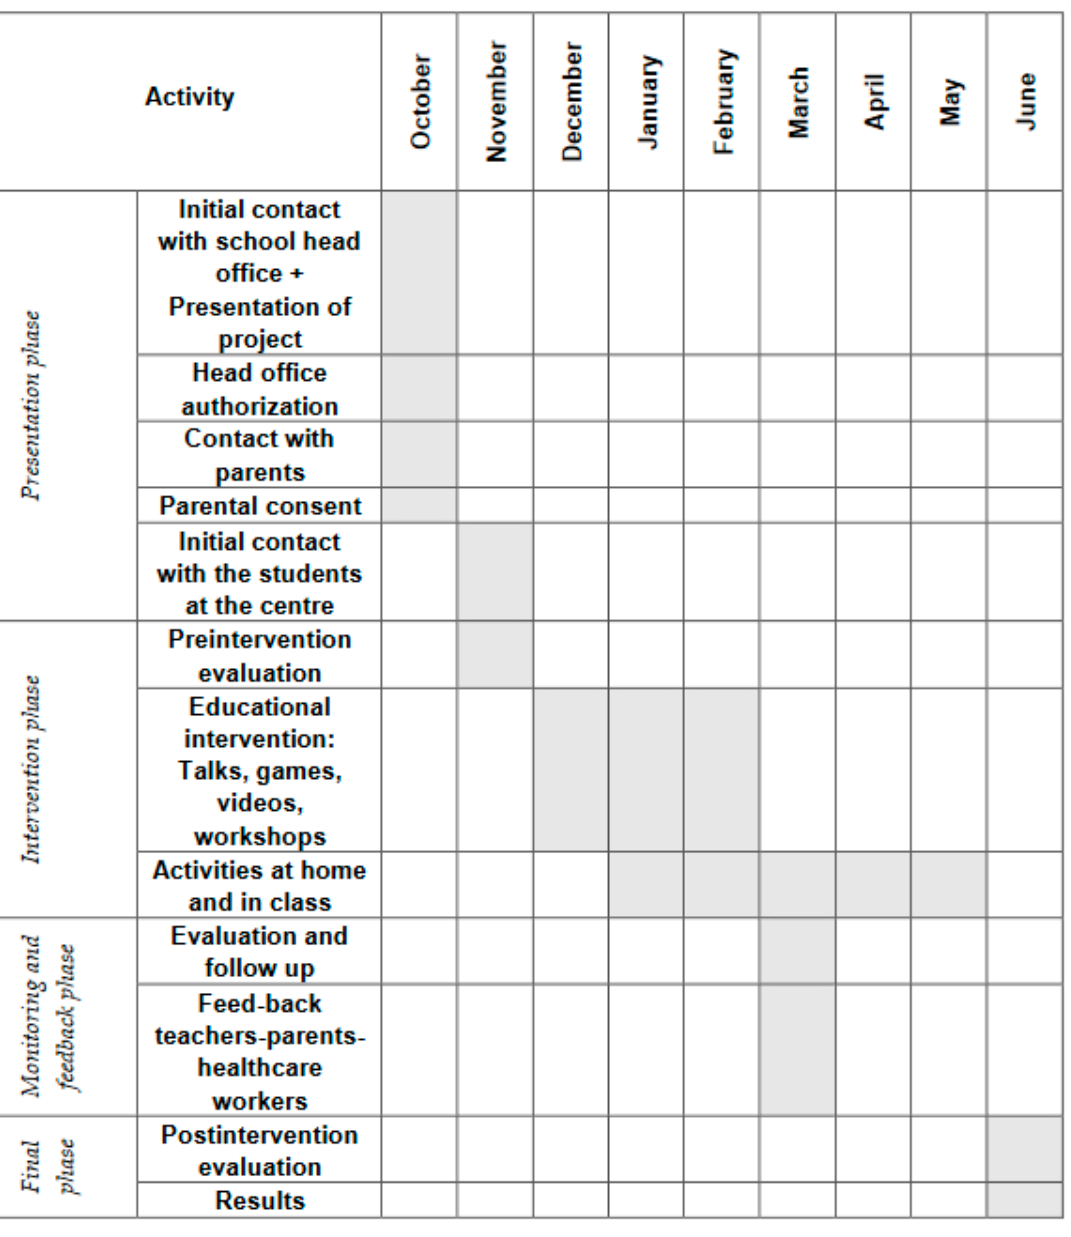
Figure 1. Intervention